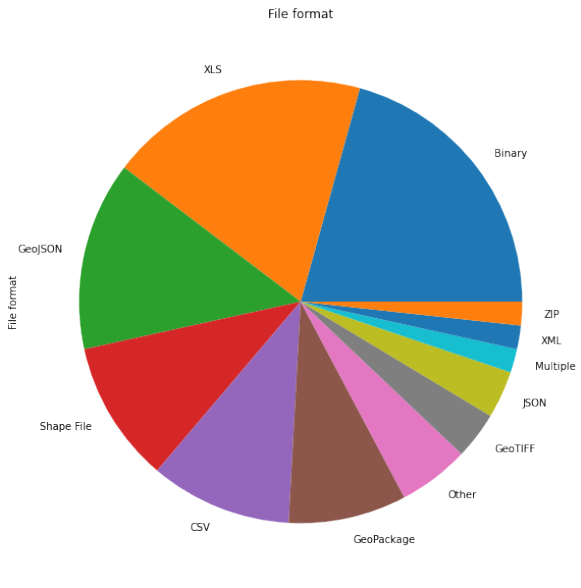
Figure 1. eMOTIONAL Cities data formats allocation